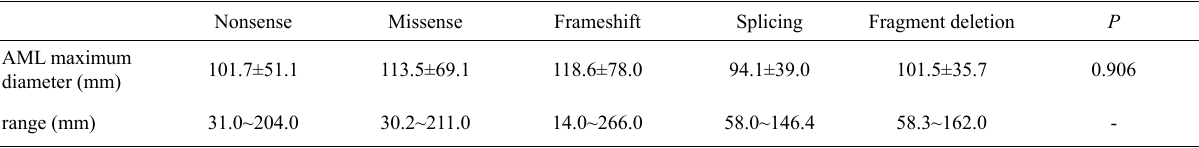
Table 5 - Comparison of AML maximal diameters among different TSC2 mutation